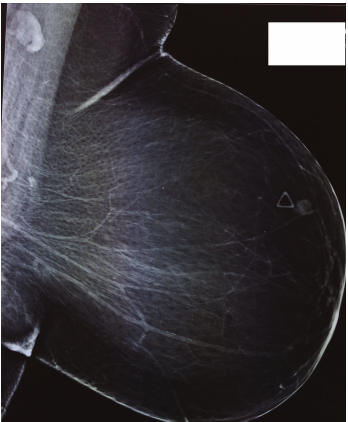
Figure 2: Left mediolateral oblique mammographic view: the mass appears superficial.